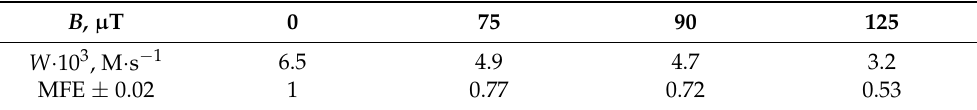
Table 3. Influence of the magnetic field strength ( B ) on the rate of adrenaline consumption ( W ) and the values of the magnetic field effect. Carbonate buffer, pH = 10.60, [Adr] 0 = 68 µ M, air atmosphere, 310 K. B, µ T 0 75 90